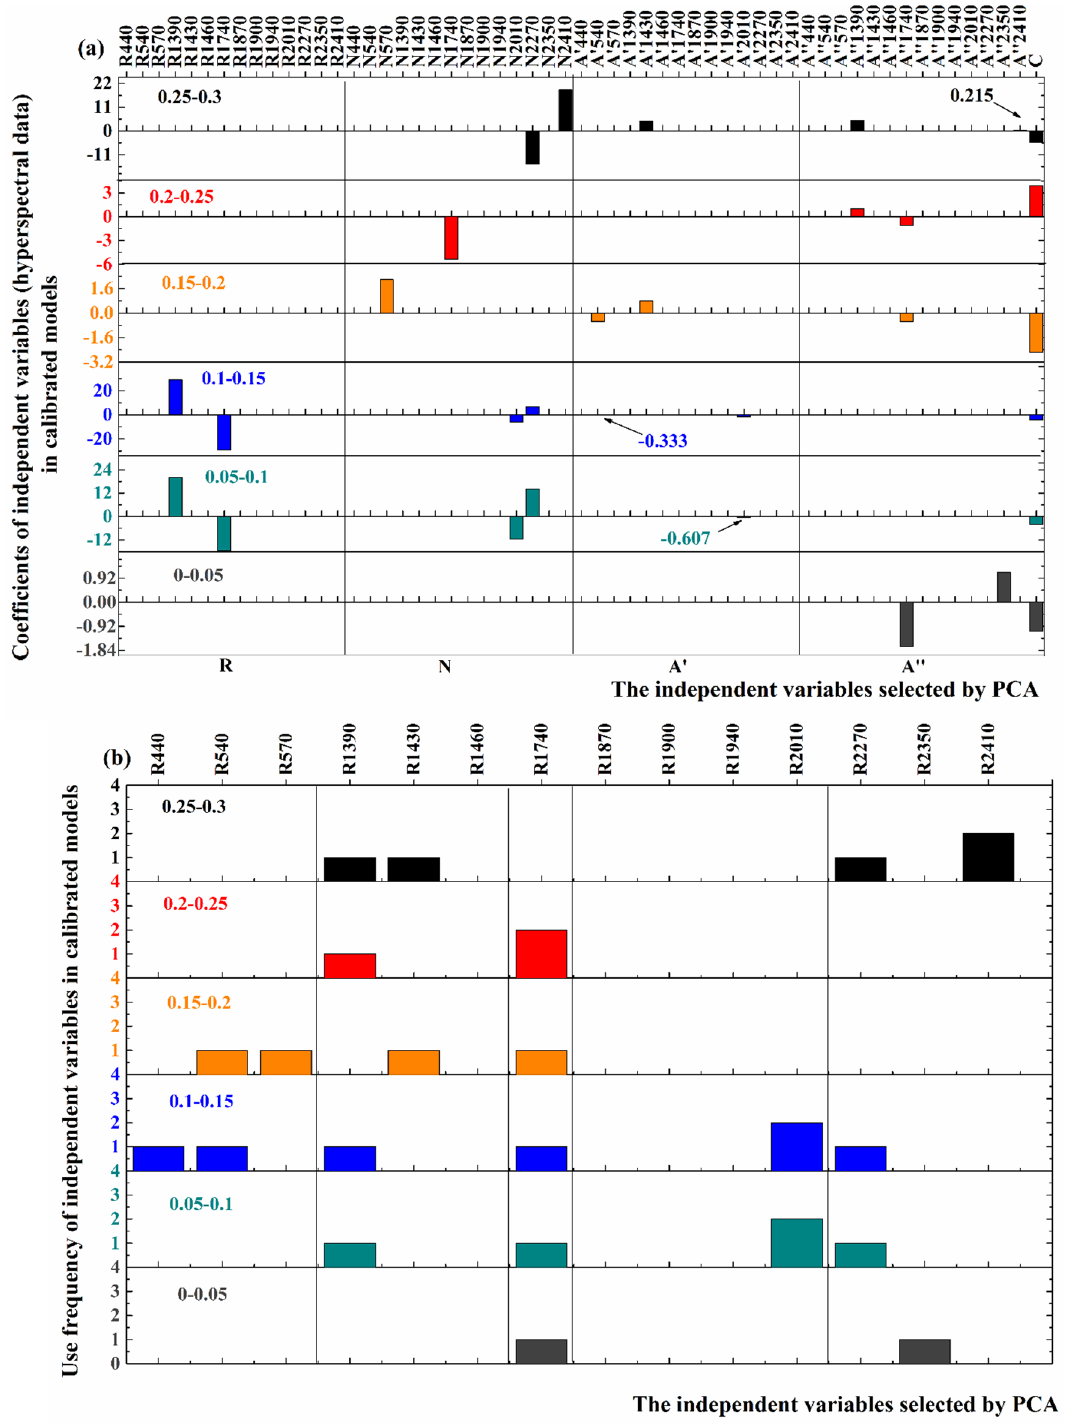
Figure 7. Bar graphs for ( a ) coefficients of laboratory SL + C + SC M_SSC SMC models for soil salt concentration (some coefficient values are too small to mark with bar plots, so values with arrows are plotted to identify them), where C (last variable on the X-axis in ( a ) is a constant in the models; and ( b ) use frequency of the coefficients/wavebands in different zones.